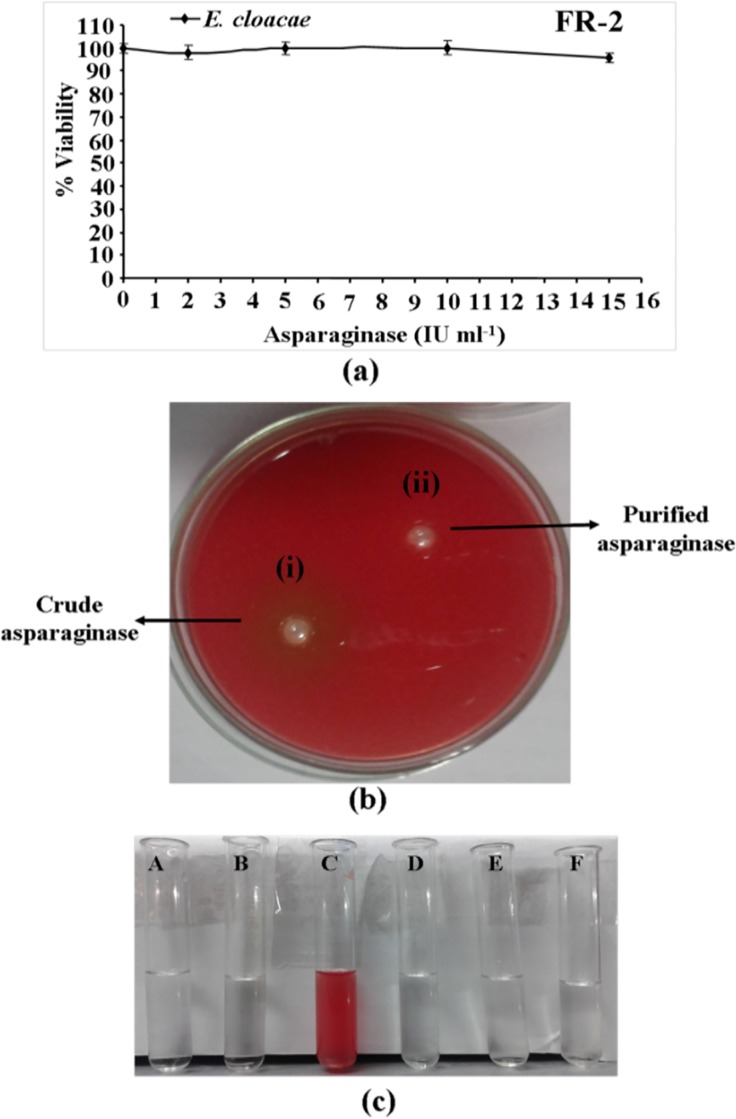
Toxicological evaluation of asparaginase purified from E. cloacae.(a) Non-toxic effects of purified asparaginase on noncancerous human epithelial cell line FR-2. Approximately, 1.5x104 cells ml-1 were cultured at 37°C and treated with 2, 5, 10, and 15 IU ml-1 concentrations of purified asparaginasefor 48 h and cell viability was determined by the MTT assay. (b(i) Crude asparaginase formed clear translucent zone on blood agar plate due to lysis of erythrocytes. (b(ii) Purified asparaginase had no hemolytic effect. (c) Quantitative measure of the haemolytic activity. A: negative control (without asparaginase); B: positive control (Phosphate buffer); C: crude asparaginase; D: 15 IU ml-1; E: 7.5 IU ml-1; F: 3.75 IU ml-1 concentrations of asparaginase.